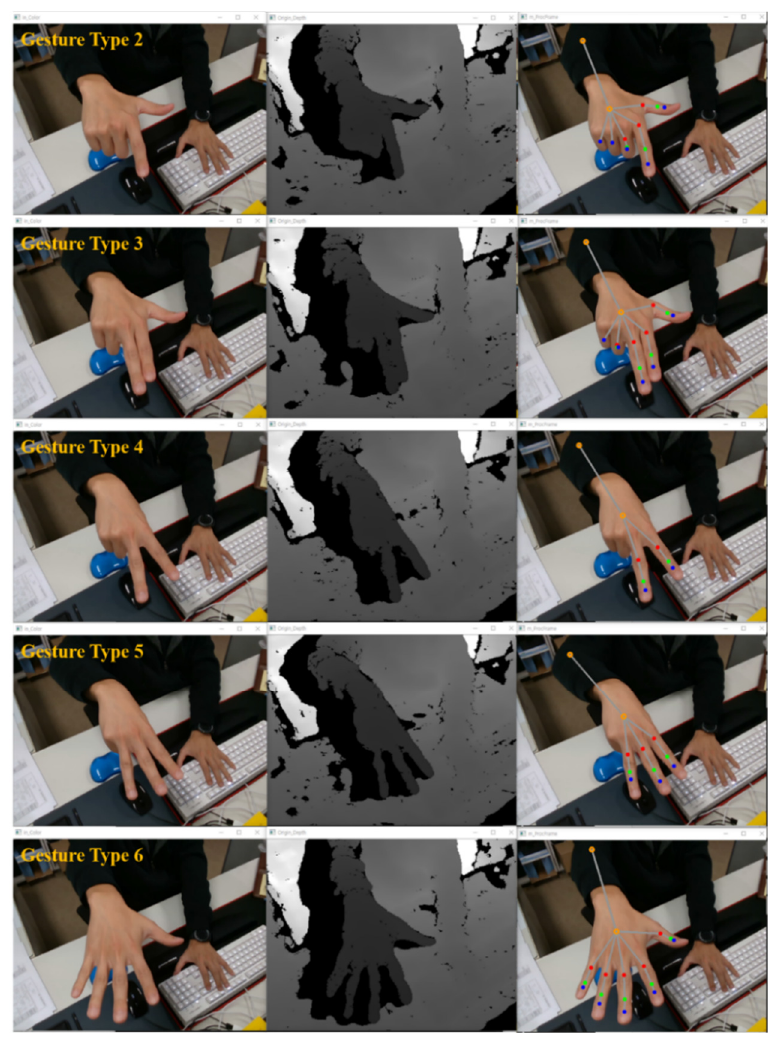
Figure 11. Various gesture detection results using the gesture recognition algorithm (Gesture Types 2~6).